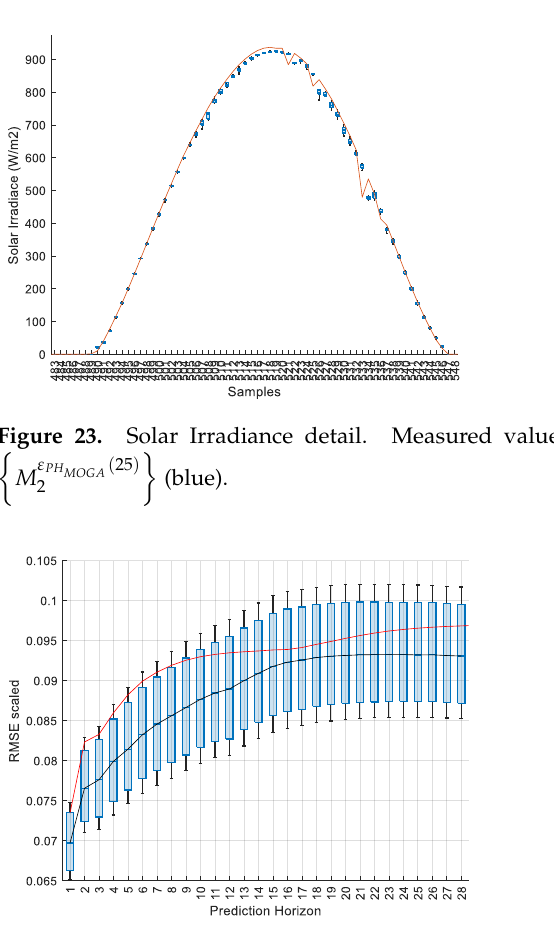
Figure 24. Evolution of RMSE over the prediction horizon — M 2 . Selected model (red) and (cid:26) (cid:27) (25) ε PHMOGA M (blue). 2